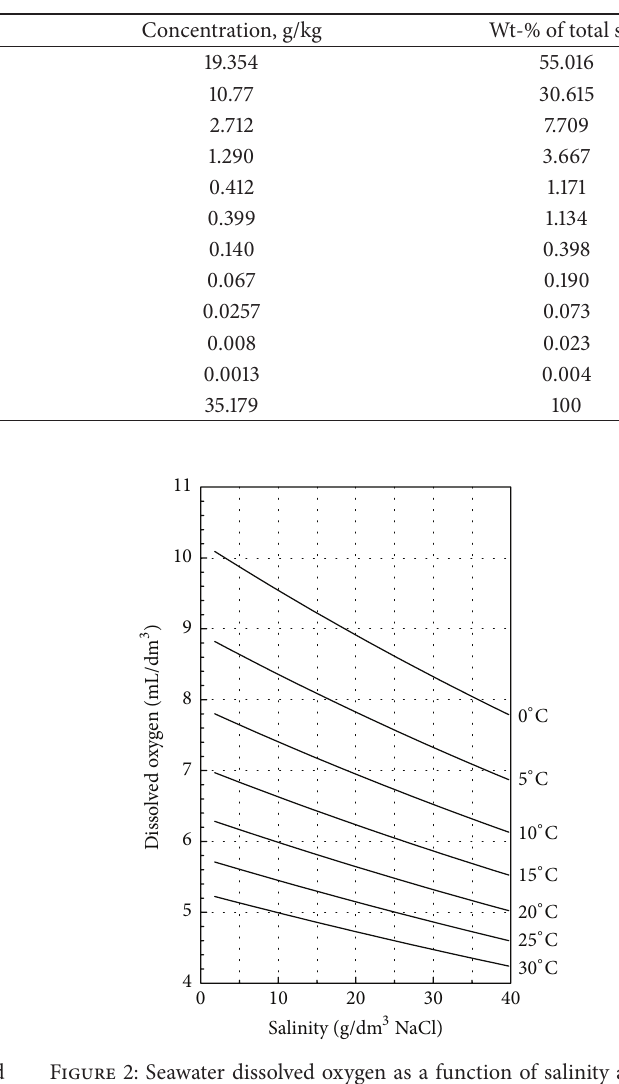
Table 1: Concentrations of the most abundant ions and molecules in seawater of 35‰ salinity and density 1.023 g/cm 3 at 25 ∘ C [1].